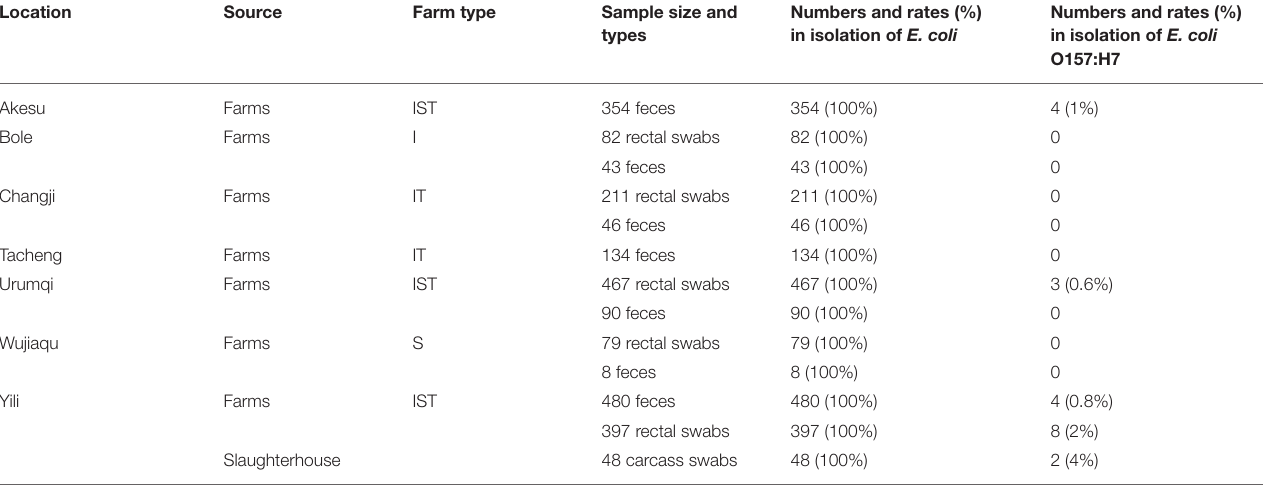
TABLE 2 | Sample collection and isolation of E. coli . Location